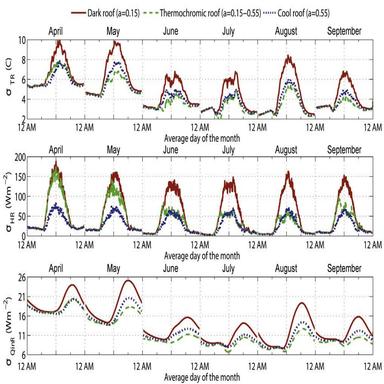
Dark, thermochromic and cool roof standard deviations of surface temperature (σTR), outward sensible heat flux (σHR) and inward heat flux (σQinR) for the monthly-averaged diurnal cycles of the six spring and summer months.